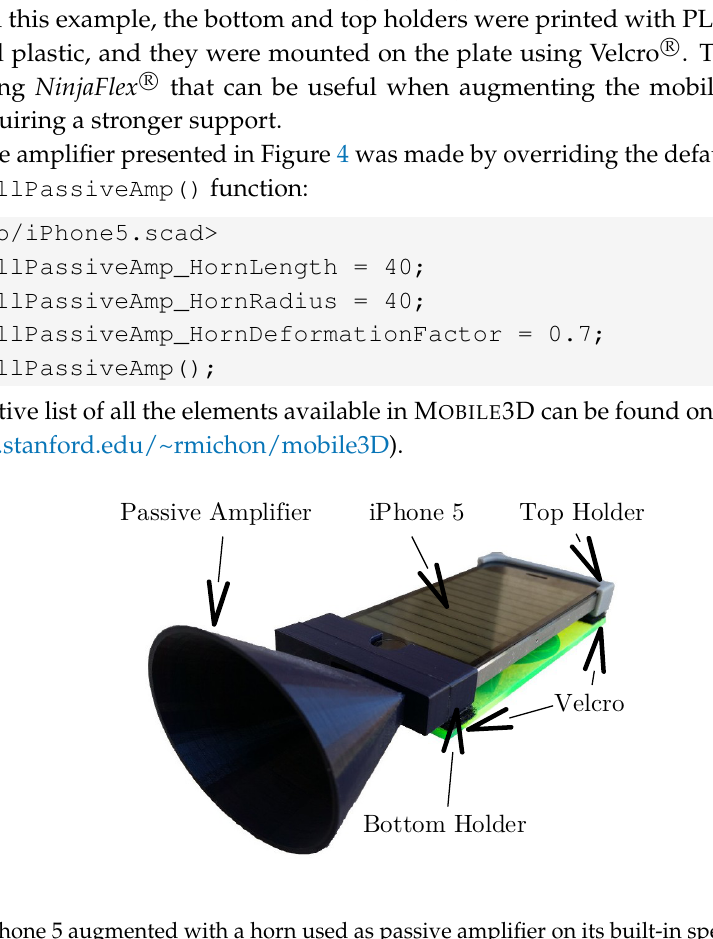
Figure 4. iPhone 5 augmented with a horn used as passive amplifier on its built-in speaker (instrument by Erin